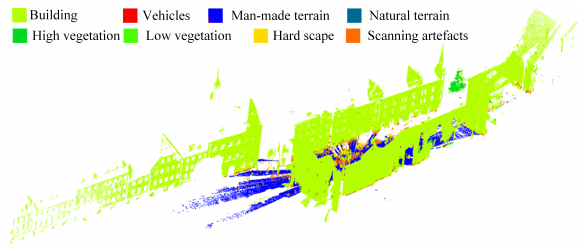
Figure 10. Classification results of the scene